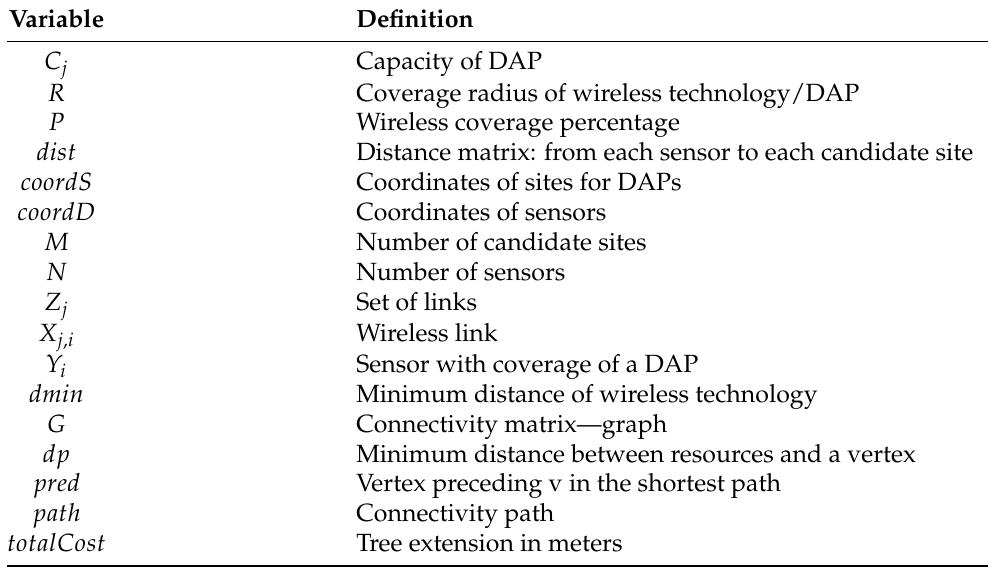
Table 2. Variables of Algorithms 1 and 2.